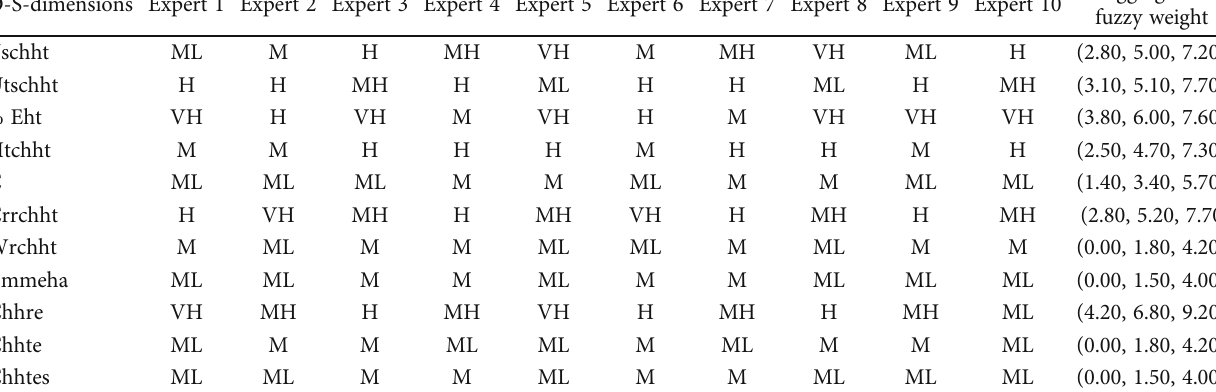
Table 5: Fuzzy weight vs. TEHES-O-S-tube material dimensions for assessing